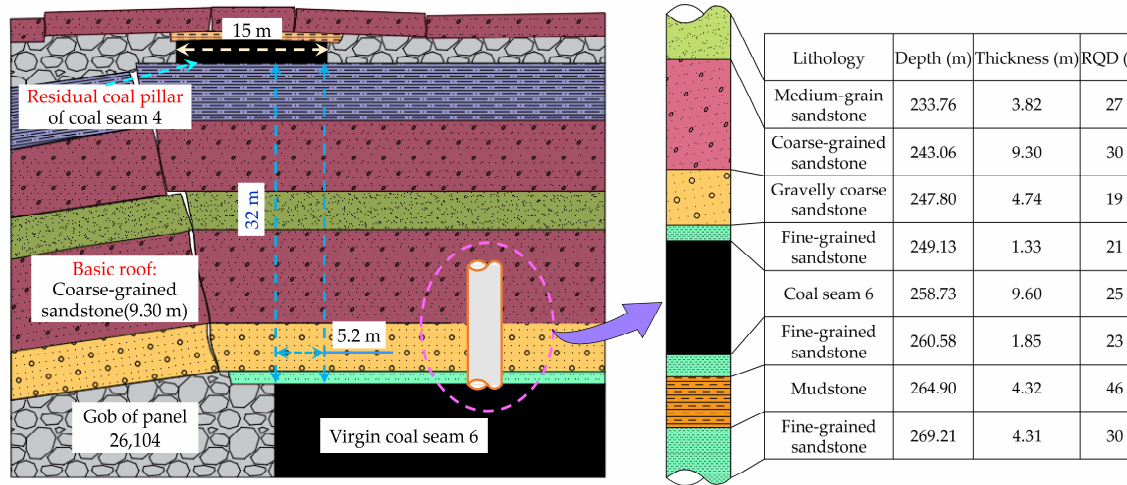
Figure 1. Generalized stratigraphic column of the test site with the panel layout.